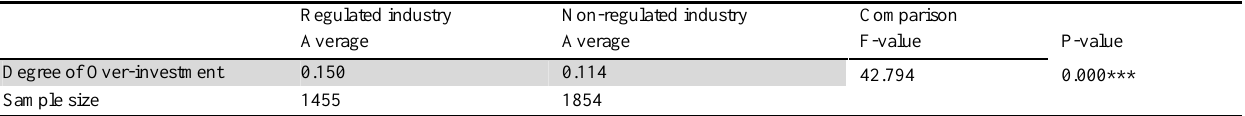
Independent Samples Test Regulated industry Non-regulated industry Comparison Average Average F-value P-value